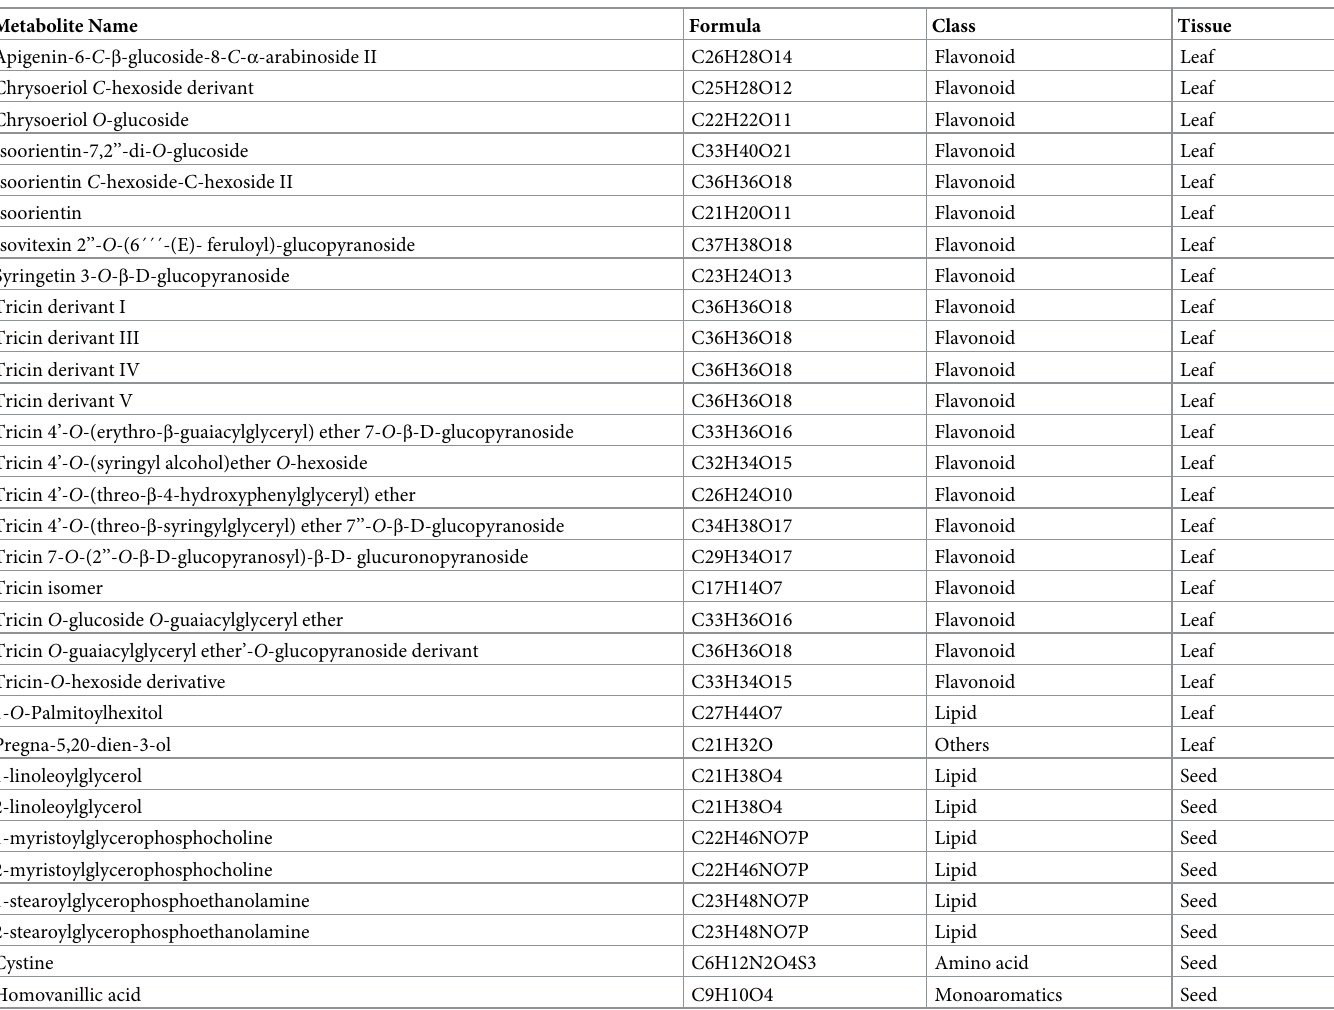
Table 2. Metabolites detected only in rice flag leaf or